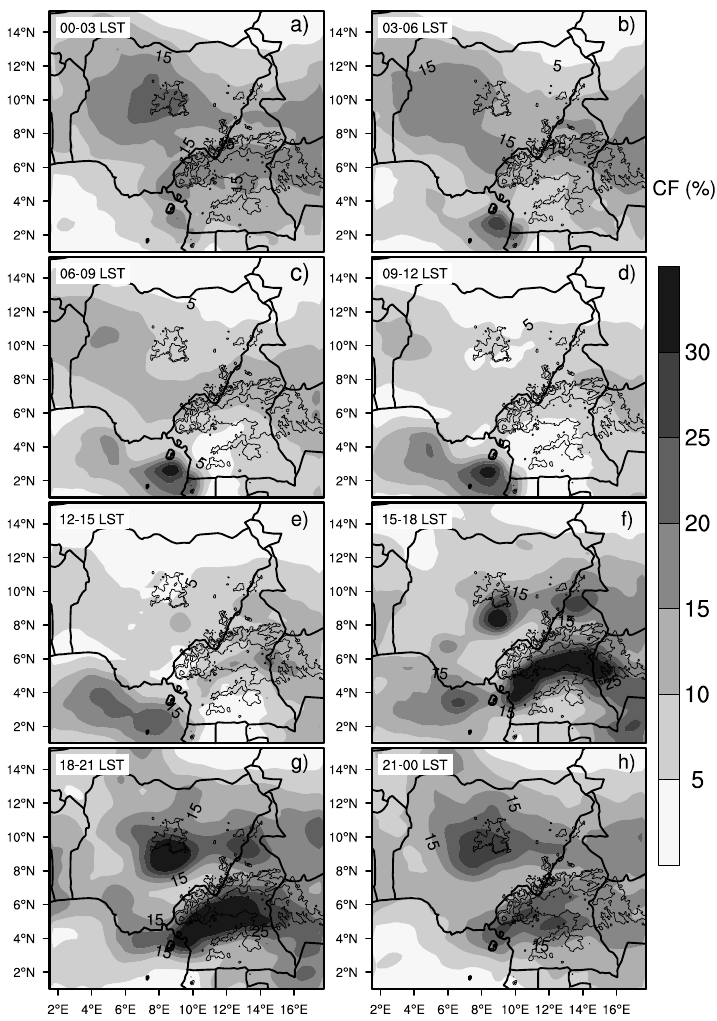
Figure 7. Mean spatial distribution of the diurnal cycle of convective activity computed < 233 K during June, July, and August shown at 3 hour intervals ( a ) 00–03 at T b